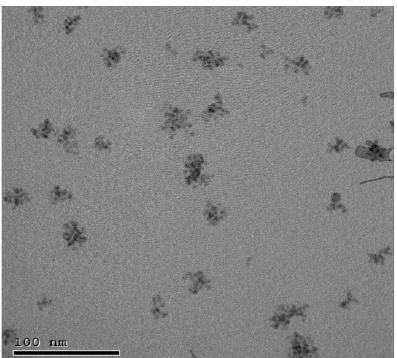
Fig. 2. The TEM images and HR-TEM images of the flower like-shaped Fe 3 O 4 /CdSe nanocomposite